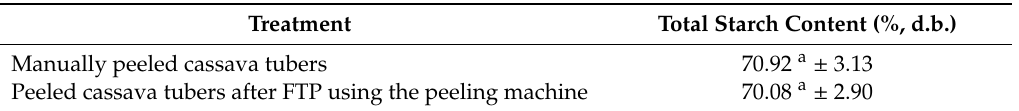
Table 6. Comparison of starch content of peeled cassava tubers after FTP using the peeling machine at optimum conditions and manually peeled cassava